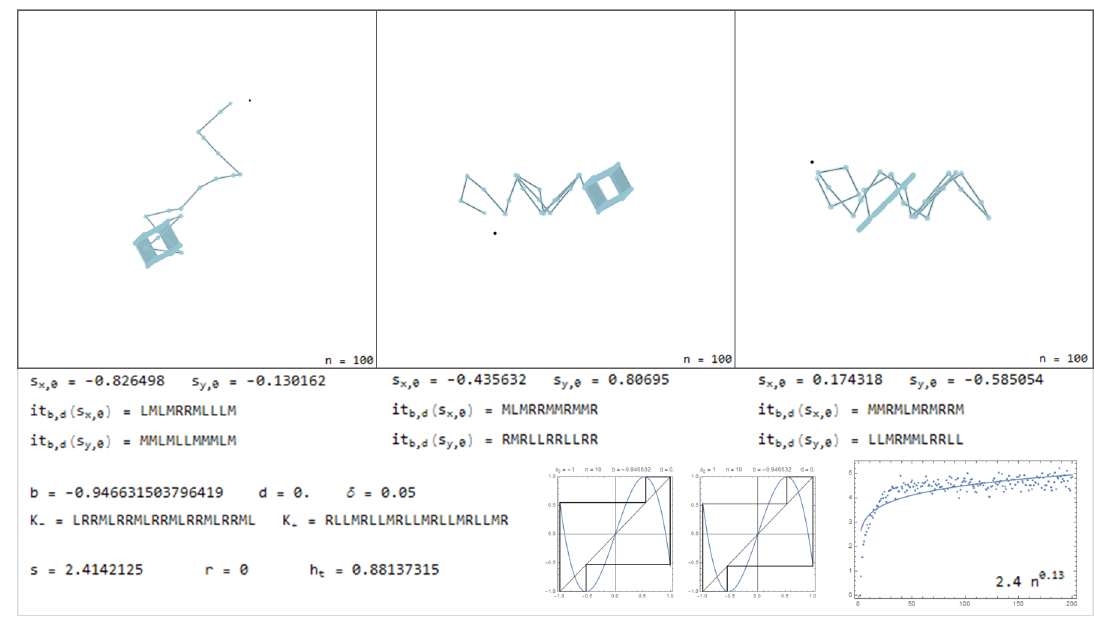
Figure 18. Trajectories produced with b = − 0.9466315 . . . and d = 0.